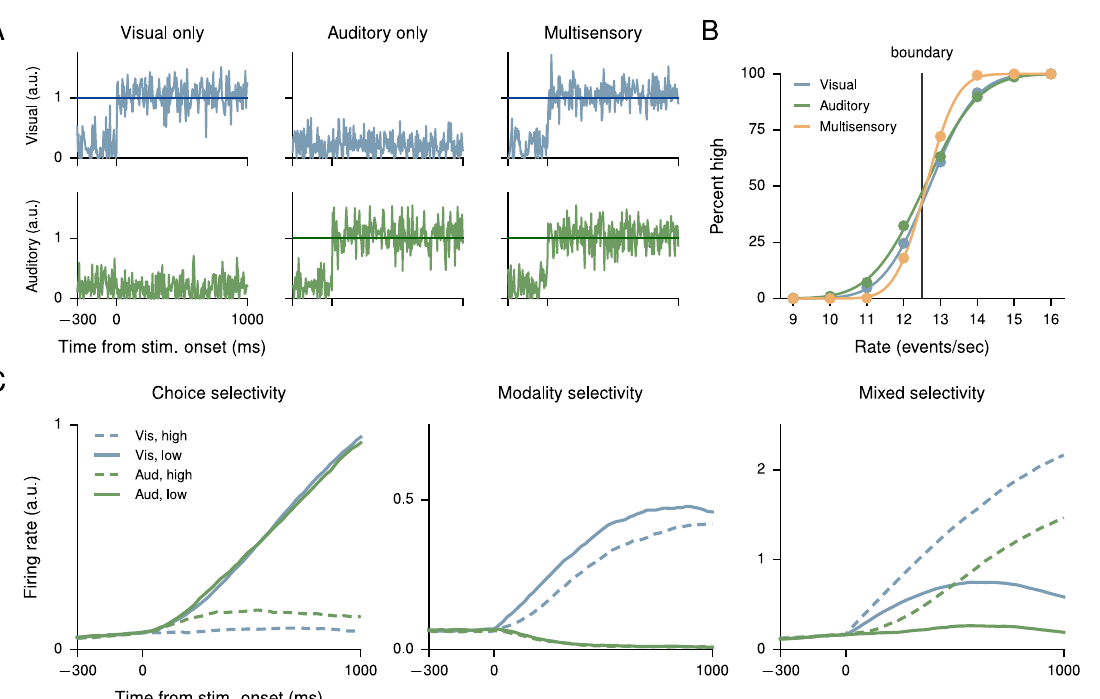
Fig 6. Multisensory integration task. (A) Example inputs for visual only (left), auditory only (middle), and multisensory (both visual and auditory, right) trials. Network units receive both positively tuned (increasing function of event rate) and negatively tuned (decreasing function of event rate) inputs; panels here show positively tuned input corresponding to a rate of 13 events/sec, just above the discrimination boundary. As in the single-stimulus perceptual decision- making task, the outputs of the network were required to hold low during “ fixation ” (before stimulus onset), then the output corresponding to a high rate was required to hold high if the input was above the decision boundary and low otherwise, and vice versa for the output corresponding to a low rate. (B) Psychometric functions (percentage of choice high as a function of the event rate) for visual, auditory, and multisensory trials show multisensory enhancement. (C) Sorted activity on visual only and auditory only trials for three units selective for choice (high vs. low, left), modality (visual vs. auditory, middle), and both (right).